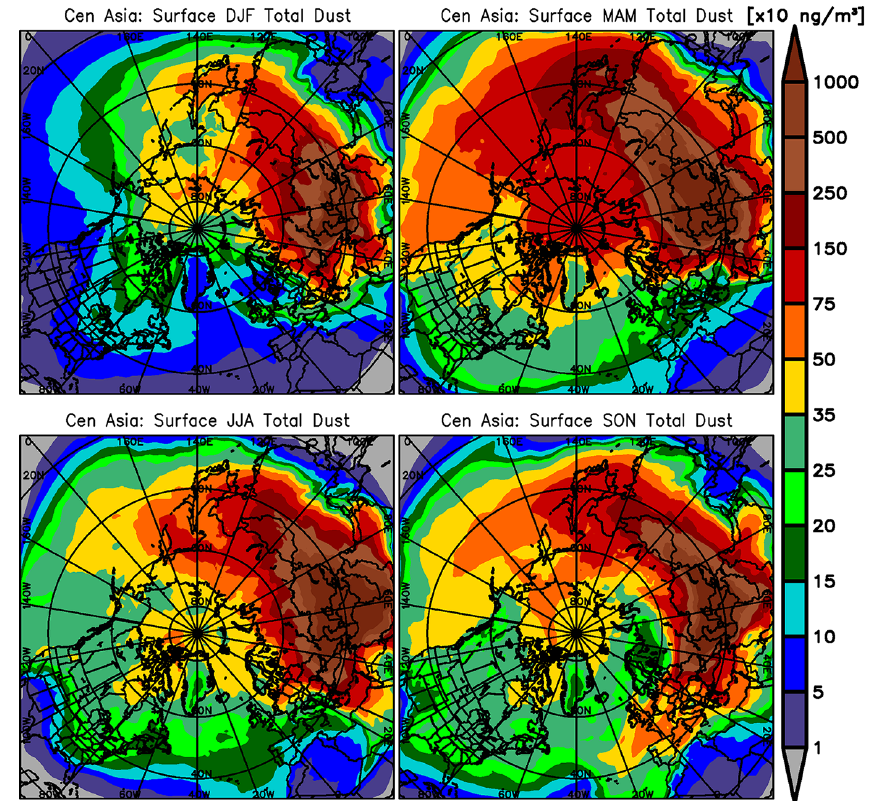
Figure 17. Seasonally averaged surface total dust (PM 10 ) concentrations from Central Asian dust emissions. DJF (top left panel) denotes the average for the months of December, January, and February. MAM (top right panel) denotes the average for months of March, April, and May. JJA (bottom left panel) denotes the average for months of June, July, and August. SON (bottom right panel) denotes average for months of September, October, and November.